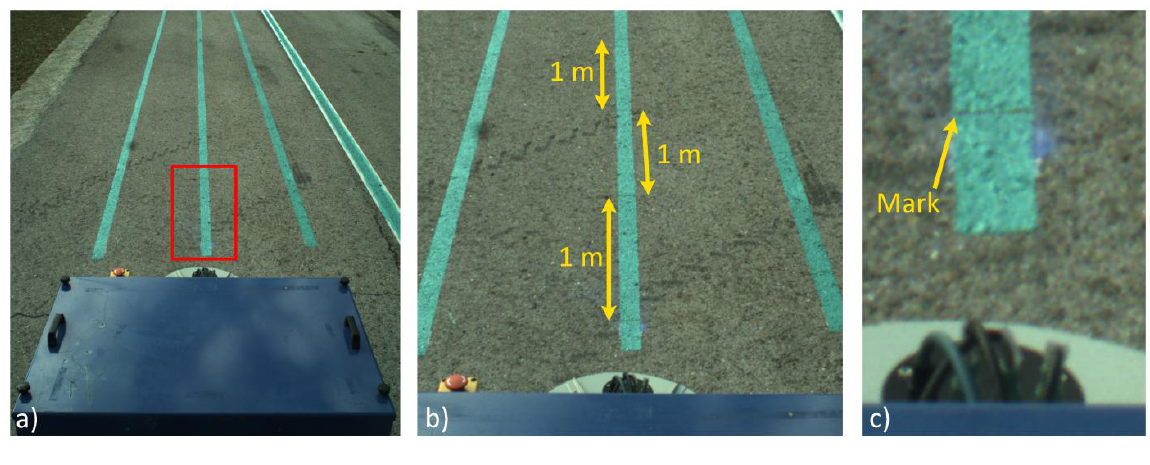
Figure 10. The test conducted for computing the longitudinal error of the vision system. Image acquired and diverse zooms. ( a ) Original image; ( b ) 200% zoom; 1 m apart between marks; ( c ) 800% zoom; mark location: pixel(y) =